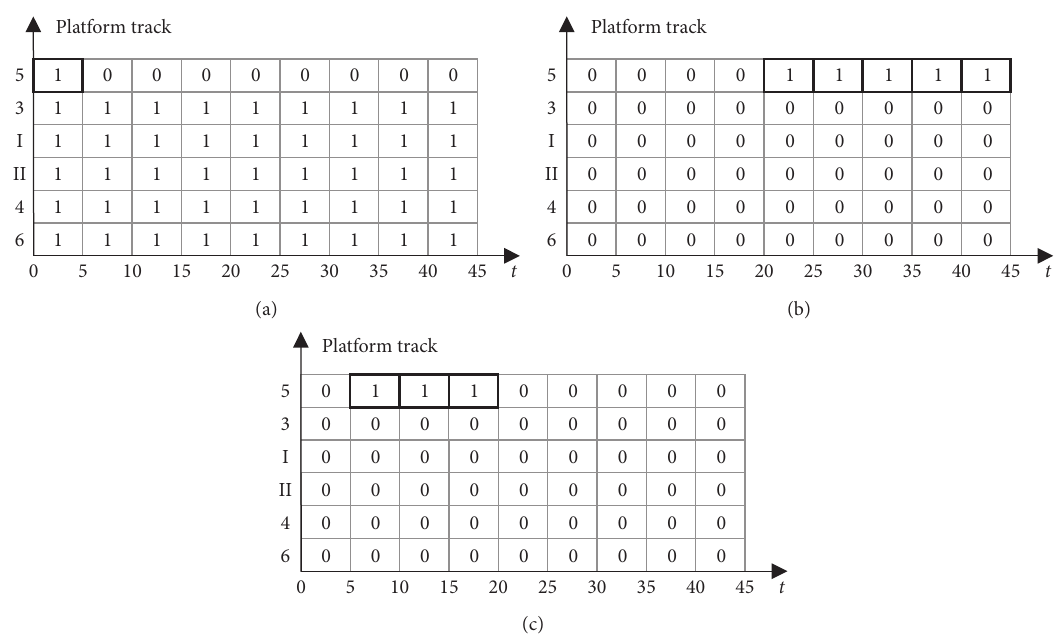
v x l,i,t , l,i,t , and l,i,t : (a) values of the variable u l,i,t ;